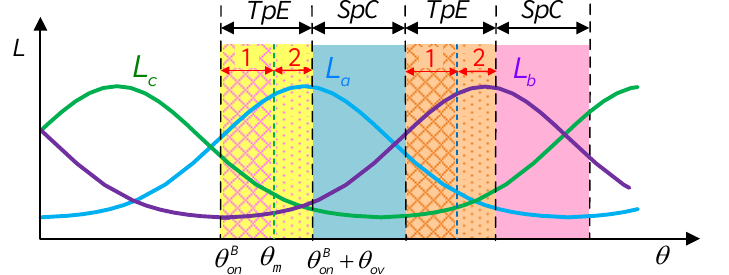
Figure 6. Region allocated diagram of NUTSF control based on inductance characteristics.